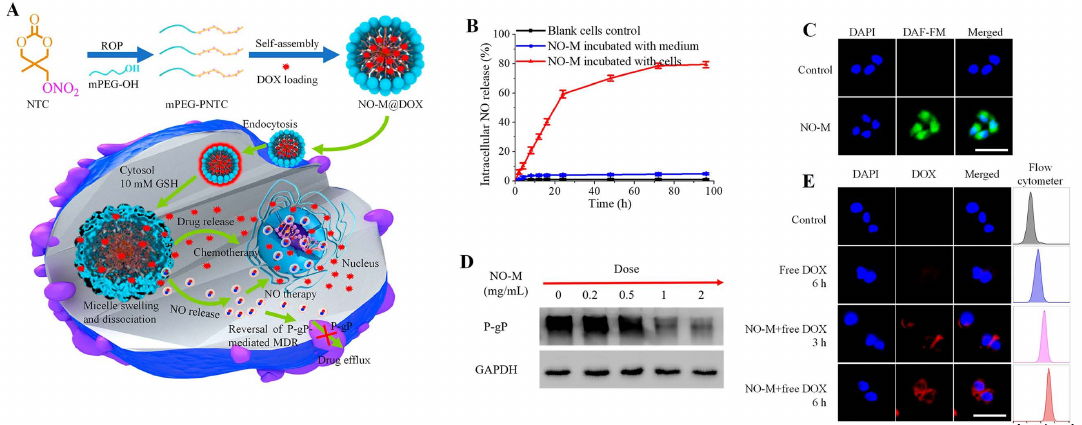
Figure 5. ( A ) Schematic illustration of the synthesis of nitric oxide donor-containing polycarbonate-based micelles (NO-M) for reduction-triggered drug delivery. ( B ) Intracellular NO release from NO-M in MCF7 / DOX resistant cells determined by Griess reagent treatment and observed by fluorescence microscopy ( C ). ( D ) Detection of P-gP expression in MCF7 / DOX resistant cells incubated with nitric oxide donor-containing aliphatic polycarbonates (APC)-based micelles at di ff erent concentrations by Western blot assay. ( E ) Fluorescence images and flow cytometer analysis for cellular uptake of free DOX in MCF7 / DOX resistant cells with and without 24 h pretreatment of nitric oxide donor-containing micelles (1.0 mg / mL). The scale bars represent 50 µ m. Reprinted with permission from ref [119]. Copyright 2019 American Chemical